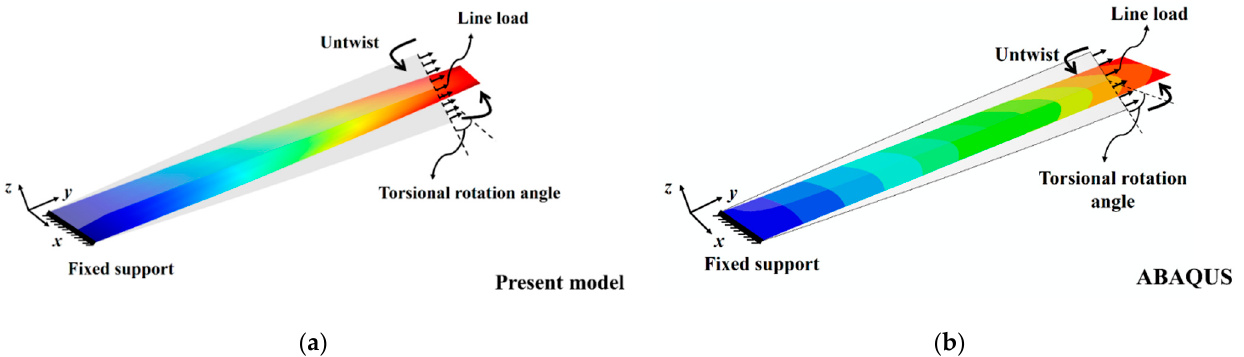
Figure 6. 3D structural configurations of a pre-twisted cantilever with rectangular cross section: ( a ) Present results; ( b ) ABAQUS results.